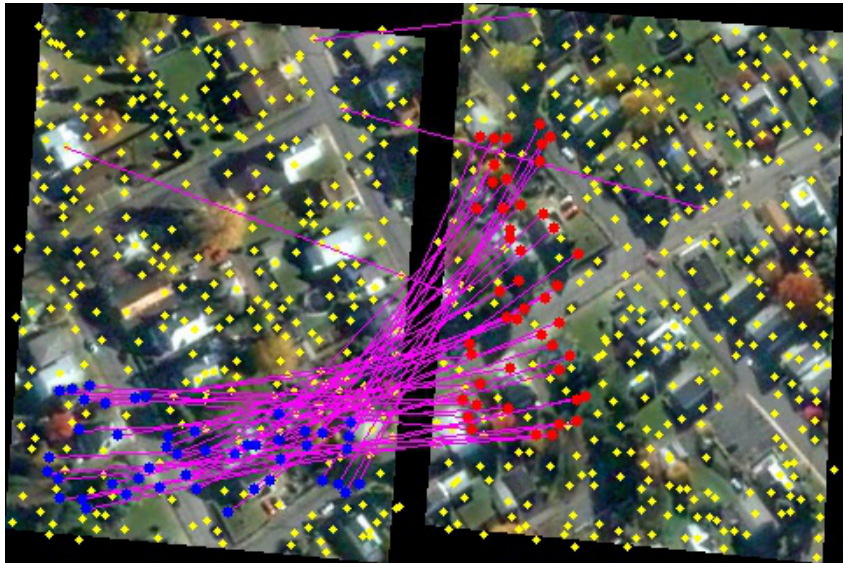
Figure 8. SIFT feature points extracted from two consecutive frames (yellow marks). Feature descriptors are matched, establishing correspondences (purple lines), which are then filtered through RANSAC obtaining a consistent subset (blue and red